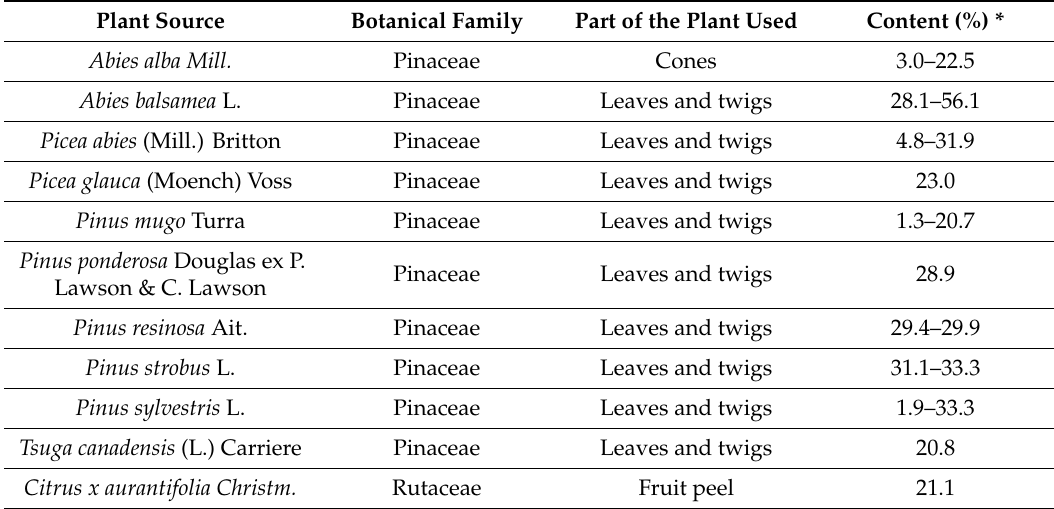
Table 7. Tree species whose total essential oil contains more than 20% of β -pinene [106]. Plant Source Botanical Family Abies alba